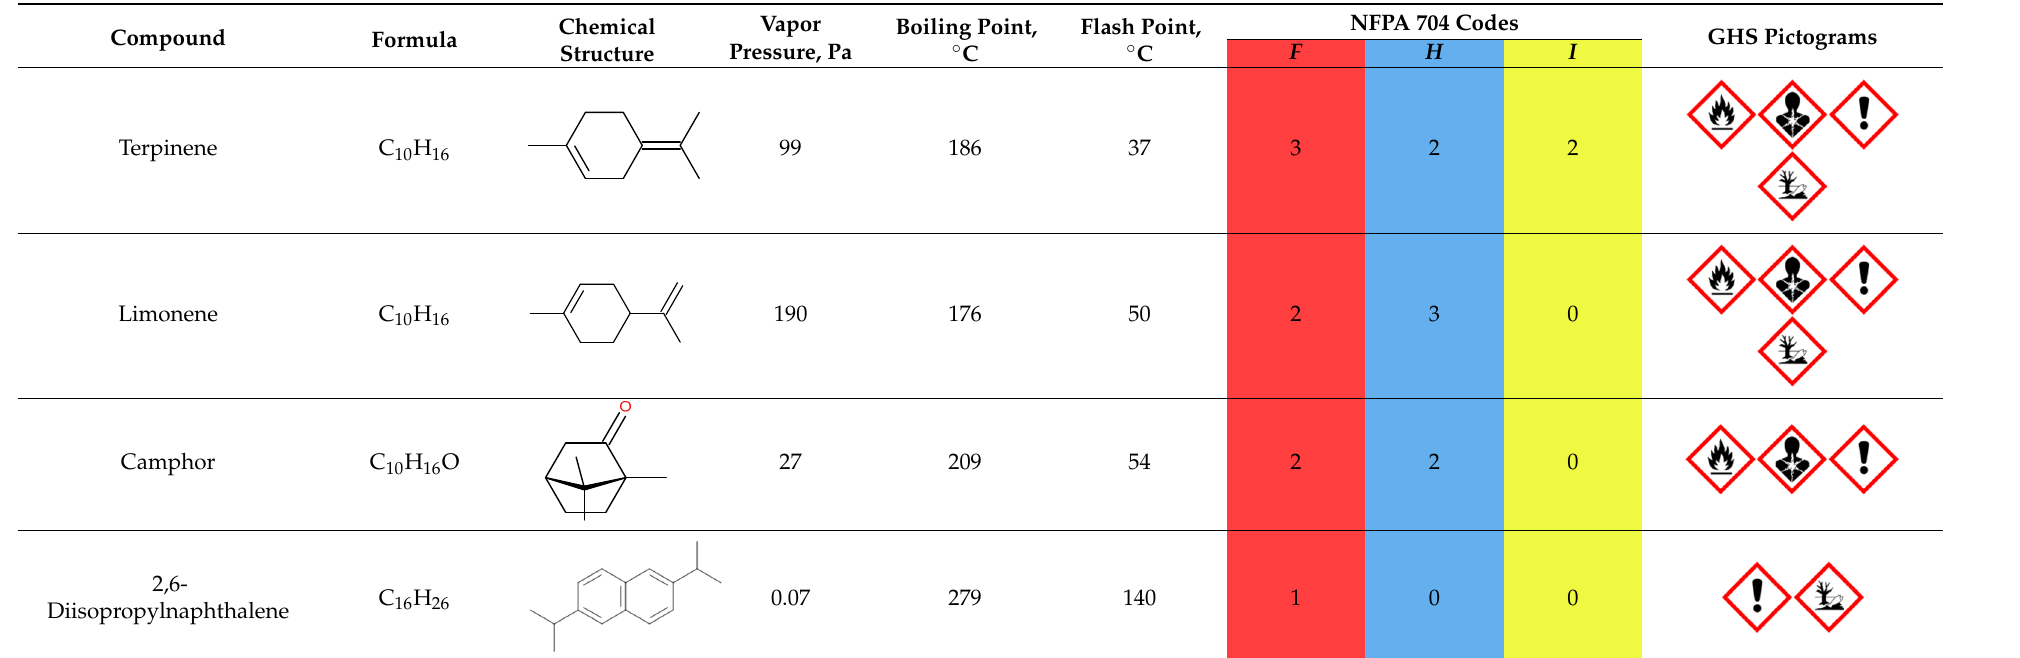
Table 2. Volatile organic compounds detected during the extrusion treatment of